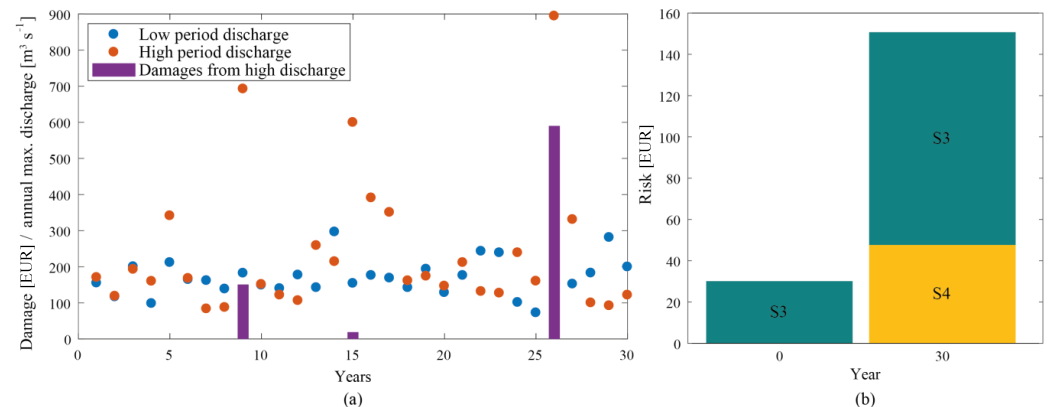
Figure 11. Example of changing risk estimate due to future observations. (a) Two different realizations of annual maximum discharges in the first period (year 1–30) and respective flood damage (lilac bars) when system S3 is implemented initially. (b) Expected future damage (i.e., risk) for the protection system life-time when S3 is implemented initially (year 0) and after 30 years for the remaining life-time in case the high period discharge was observed with (yellow)/without (petrol) adjusting to